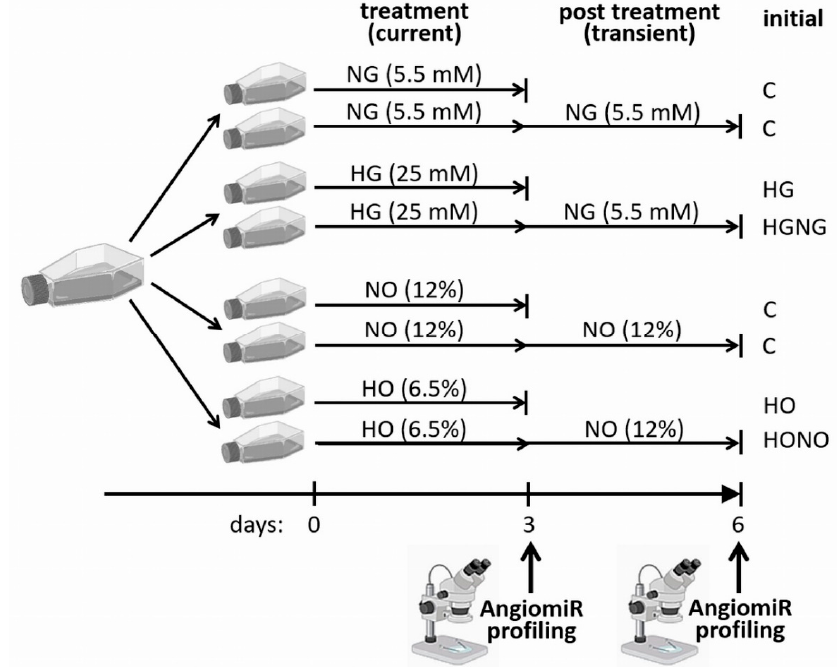
Figure 1. Experimental setup. Hyperglycemic treatment was performed with n = 10 individual fpEC isolations; hypoxic treatment was performed with n = 9 individual fpEC isolations. C: control con-